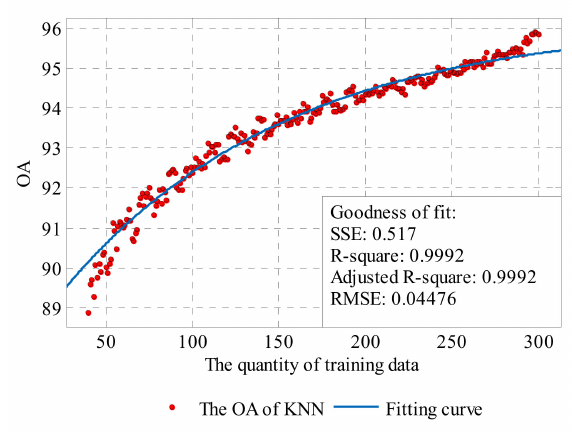
Figure 17. The exponential curve fit to the performance results of the KNN.